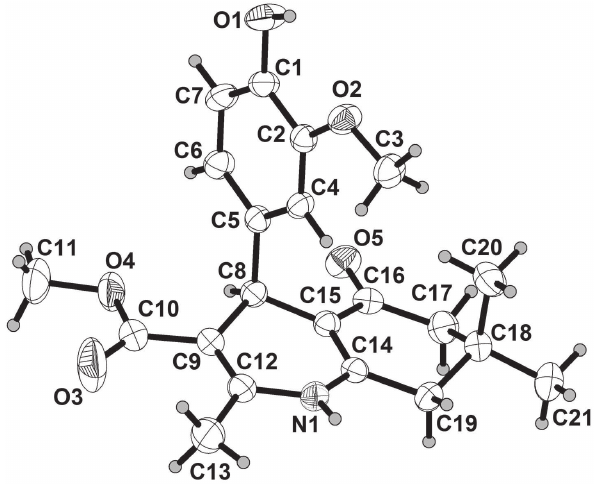
Table 2: Fractional atomic coordinates and isotropic or equivalent isotropic displacement parameters (Å 2